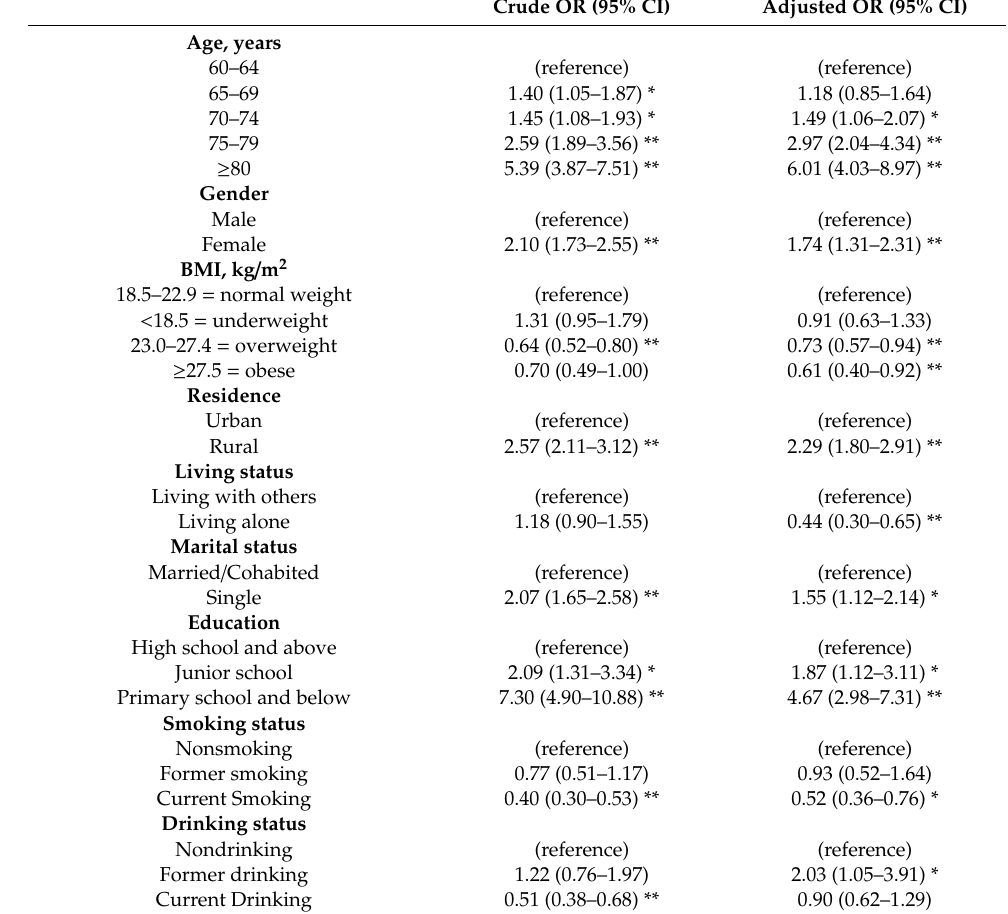
Table 2. Logistic analysis examining associations with functional disability (N =